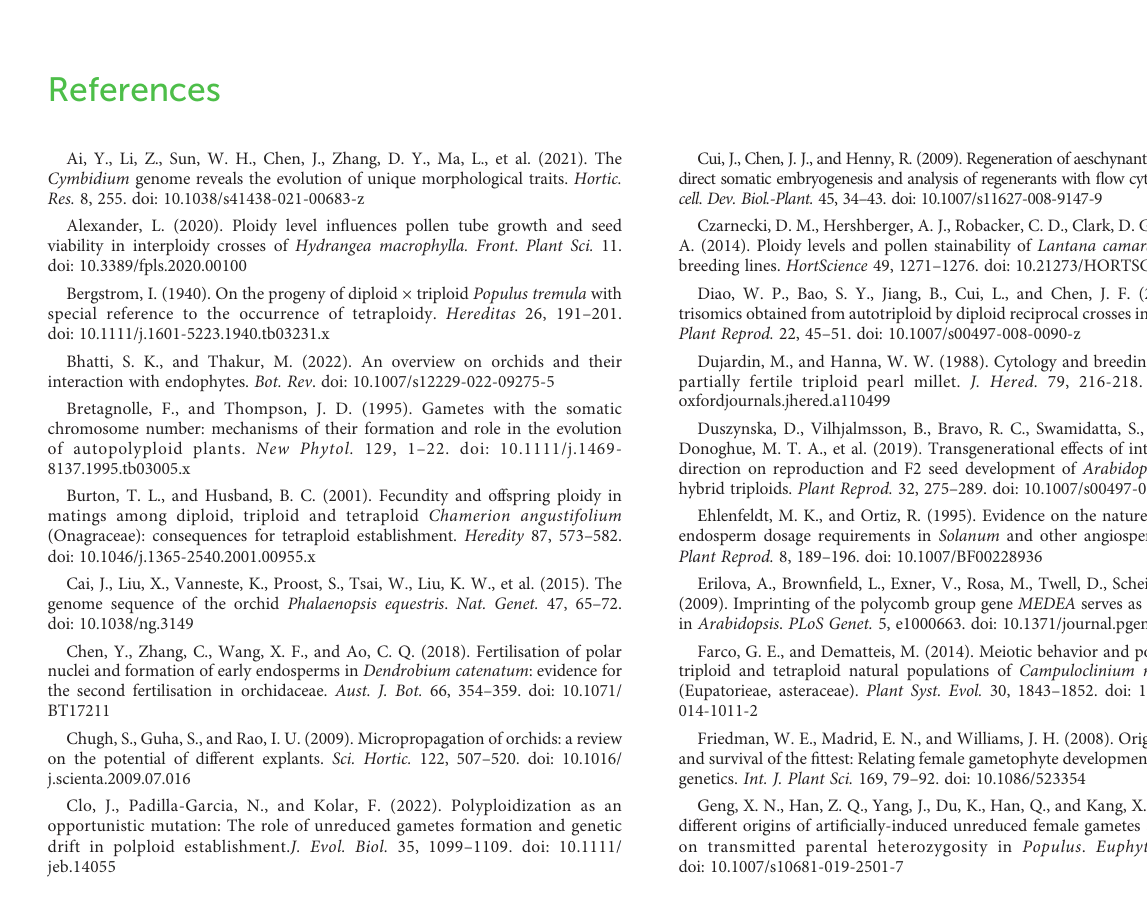
SUPPLEMENTARY FIGURE 1 Cymbidium cultivars used for hybridization. SUPPLEMENTARY FIGURE 2 Morphology of seeds, test-tube seedlings and transplanted seedlings. SUPPLEMENTARY FIGURE 3 Types of male gametes at early microspore stage in diploid and triploid Cymbidium. SUPPLEMENTARY FIGURE 4 Meiotic abnormalities of sexual triploid ‘ Huanghe ’ . SUPPLEMENTARY FIGURE 5 Meiotic abnormalities of diploid ‘ Xiaofeng ’